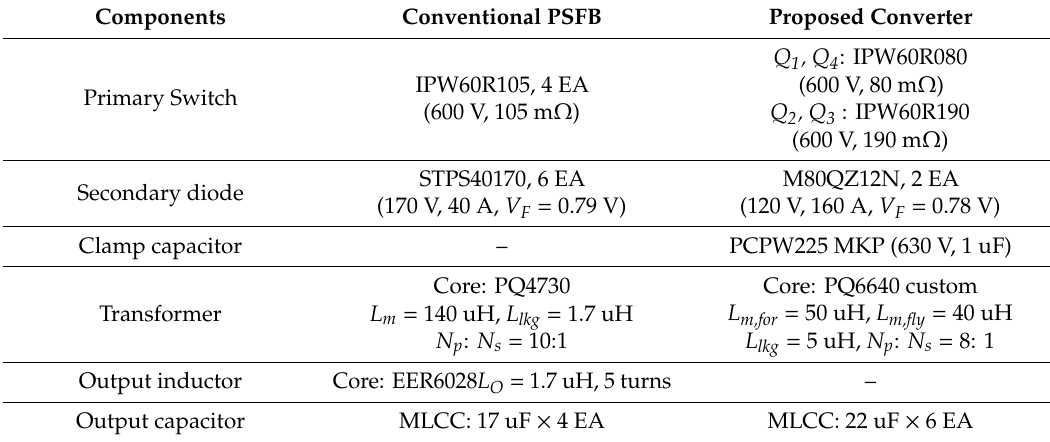
Table 3. Design Parameters.